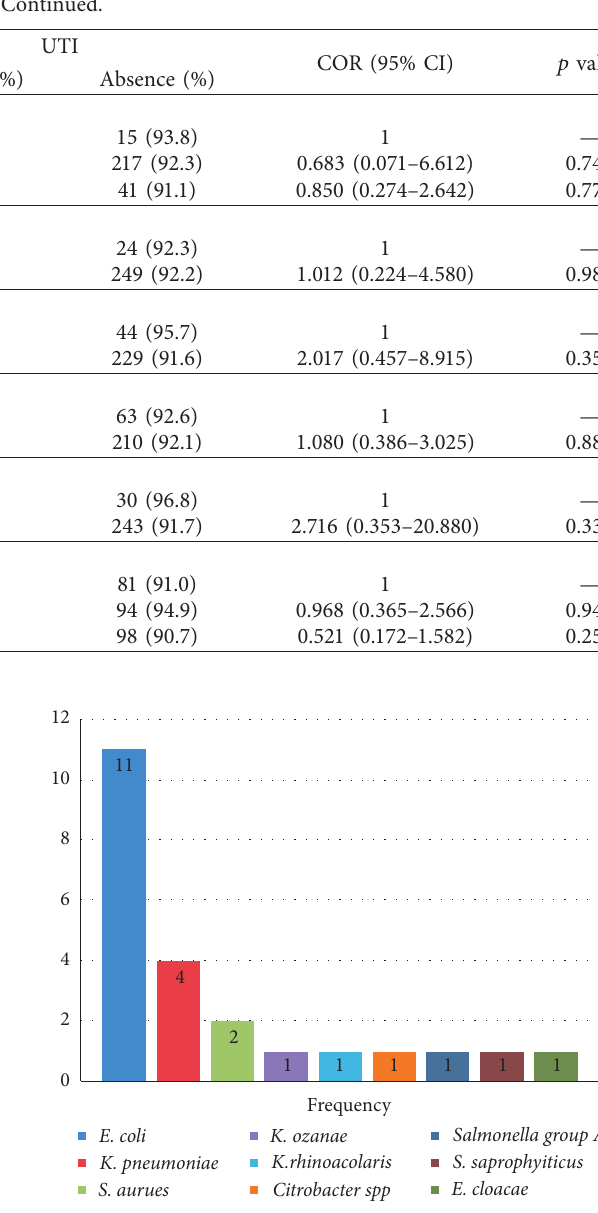
Figure 2: The bacterial profile isolated from pregnant women attending ANC at HUCSH, Southern Ethiopia, from March to June